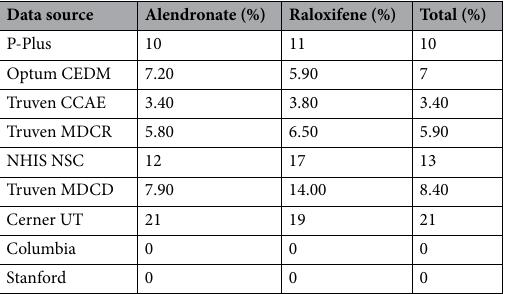
Table 2. Percentage of cohort eliminated by trimming to 0.25–0.75 preference score.